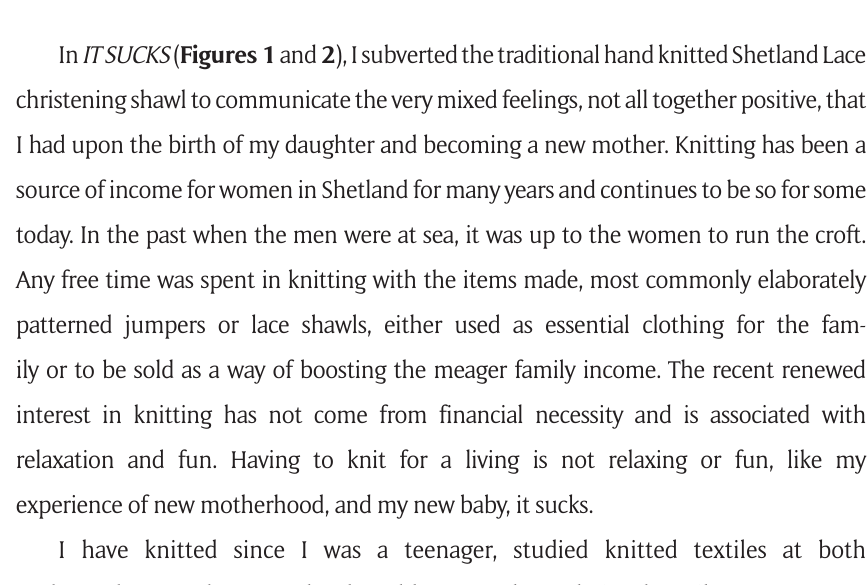
Figure 2: Installation shot of IT SUCKS in Ceremony , Pump House Gallery, London, UK 2005. Right hand wall – Rozanne Hawksley, Pale Armistice , 1991, Collection of the Imperial War Museum. Floor – Serena Korda, Love, Honour and Obey , 2004. Photograph: Colin